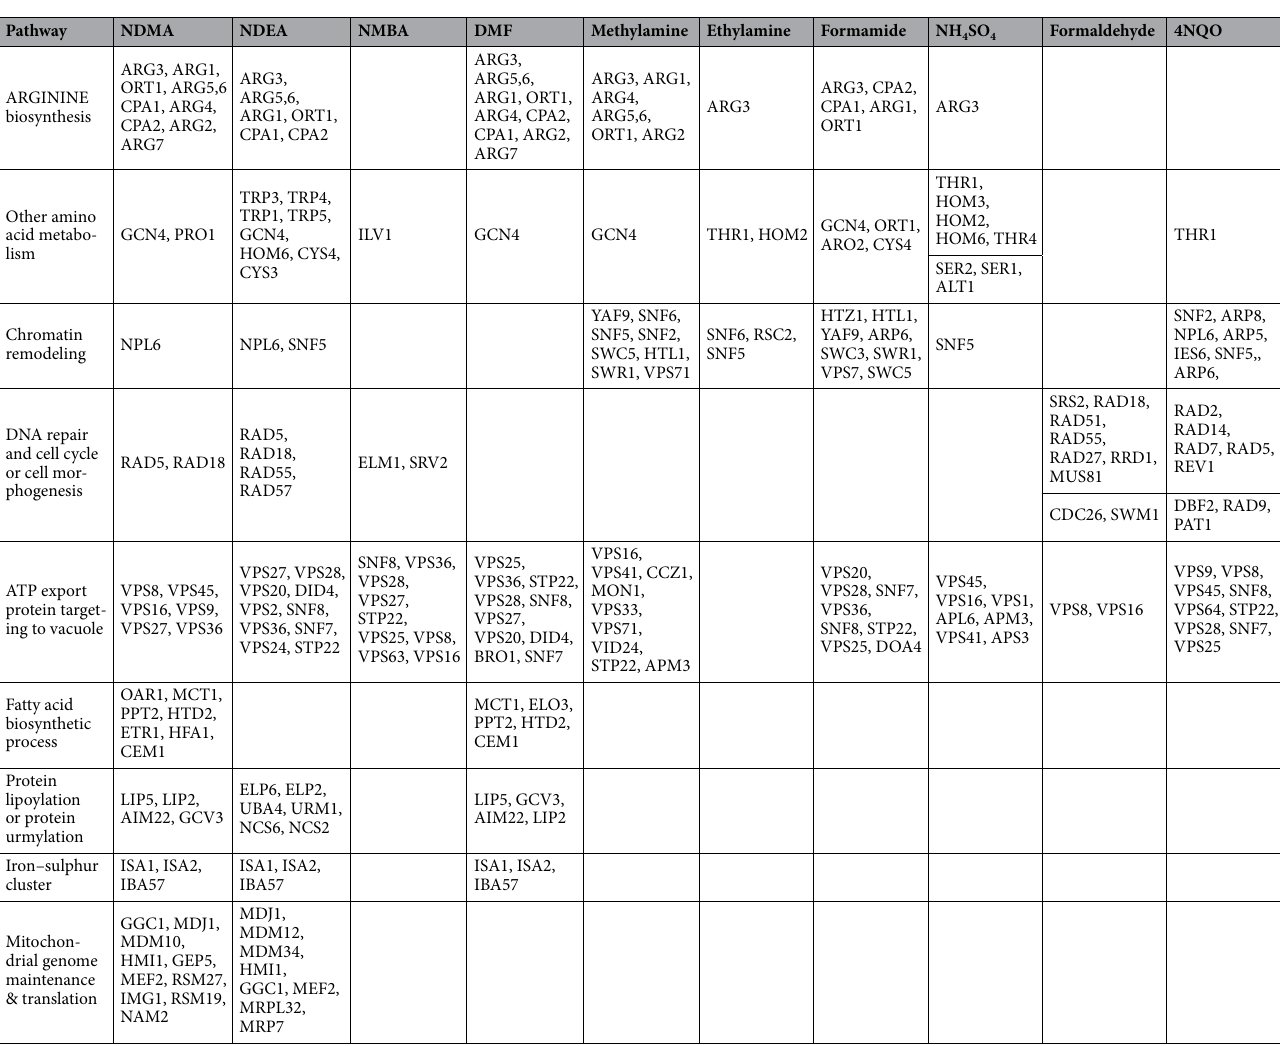
Table 1. An overview of major genes and their pathways (by nature of their deletion strains) affected by each of the 10 compounds screened. The comprehensive data can be individually assessed through